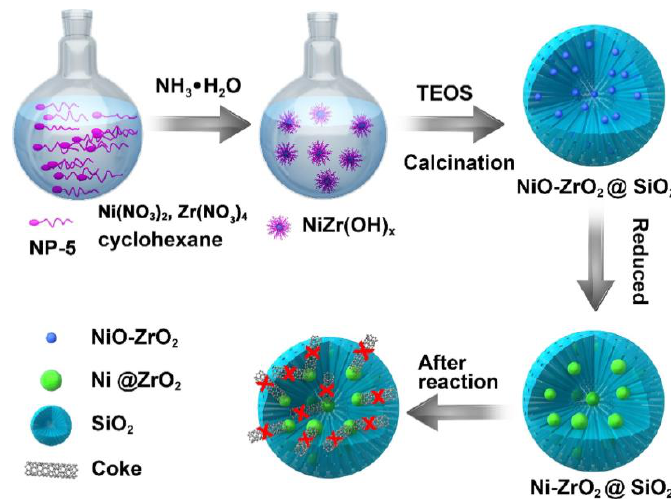
Figure 3. Illustration of the fabrication method of the Ni-ZrO 2 @SiO 2 catalyst with ultra-high coking and sintering resistance for the DRM reaction. Reproduced with permission from reference [89].